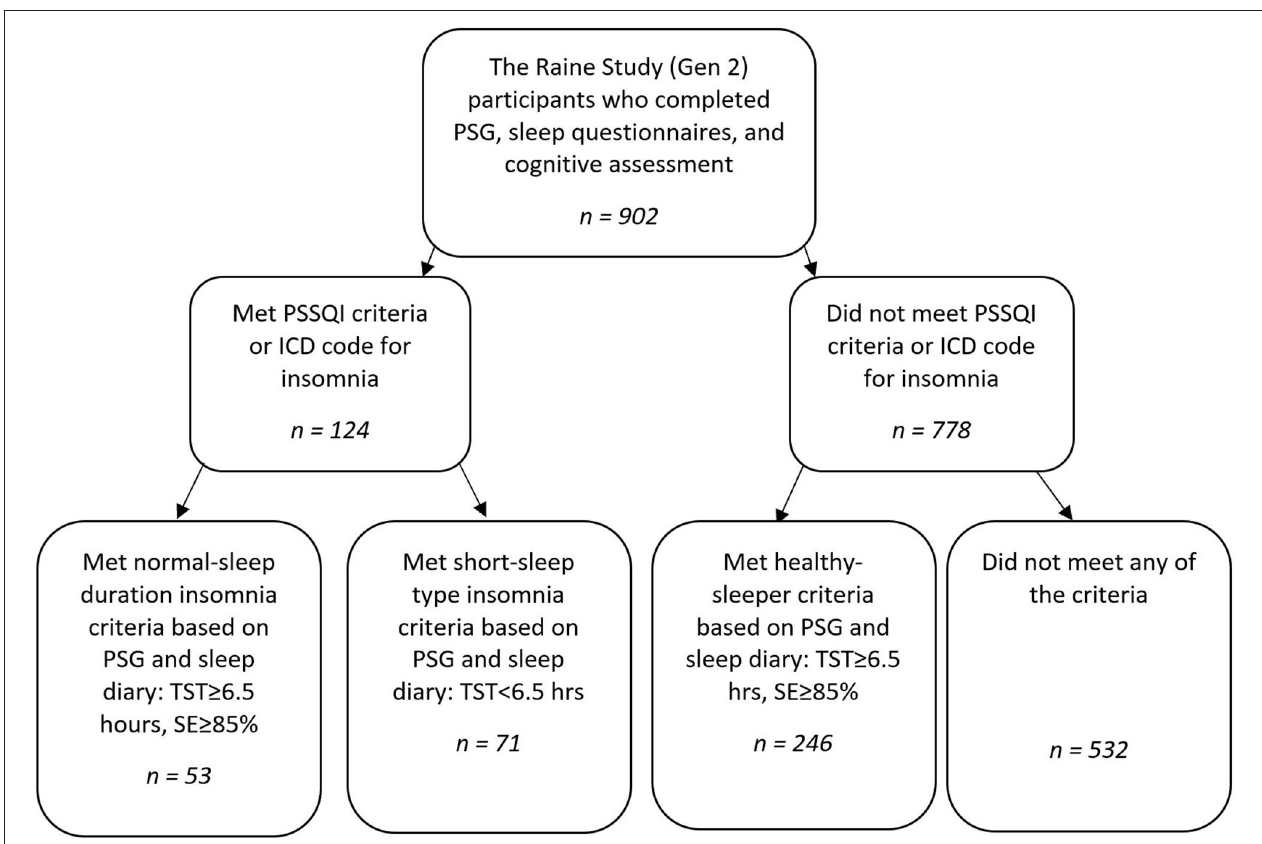
FIGURE 1 | Flow chart of study group selection for NSDI, SSDI, and healthy